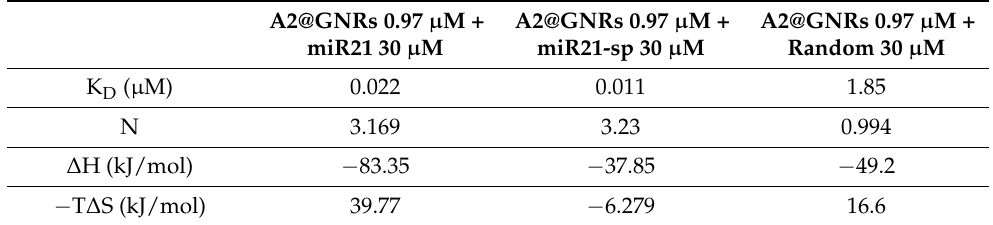
Table 3. Thermodynamic parameters for the interaction of A2@GNRs with miR21 and its